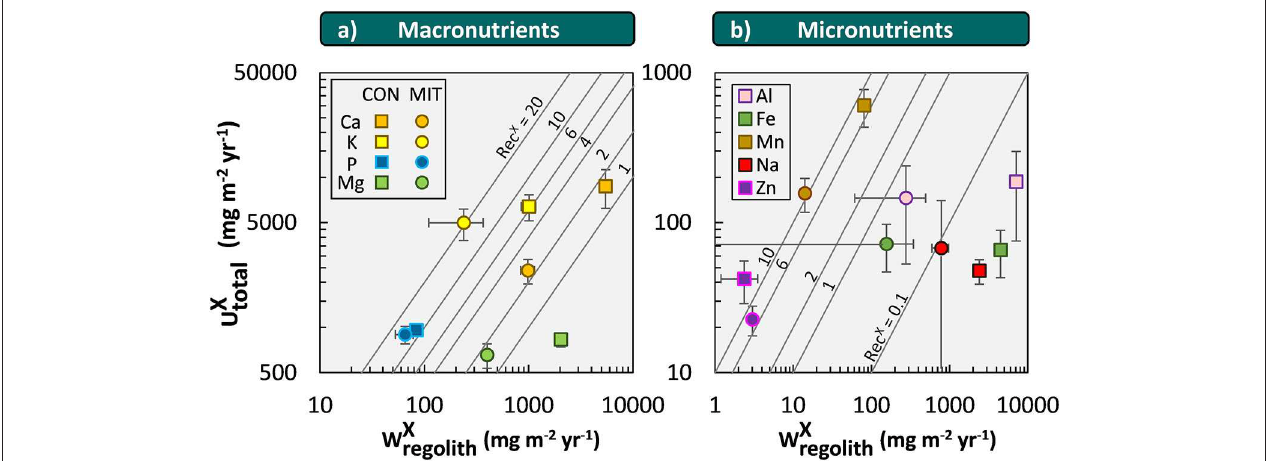
FIGURE 5 | Chemical weathering fluxes ( W X regolith ) and ecosystem nutrient uptake fluxes ( U X total ) for macronutrients (a) and micronutrients + Na (b) at CON (squares) and MIT (circles). Contour lines illustrate the nutrient recycling factor ( Rec X ), which is the ratio of U X total to W X regolith . Uncertainty bars show one standard deviation (see section Calculation of Fluxes and Inventories in Forest Ecosystems).